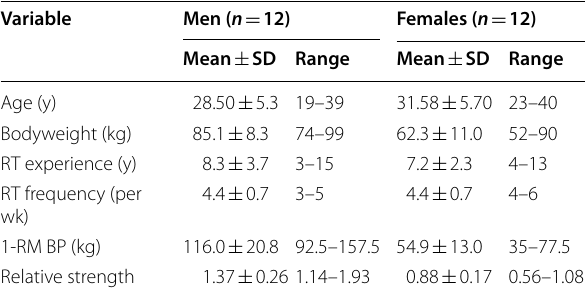
Table 1 Baseline participant characteristics